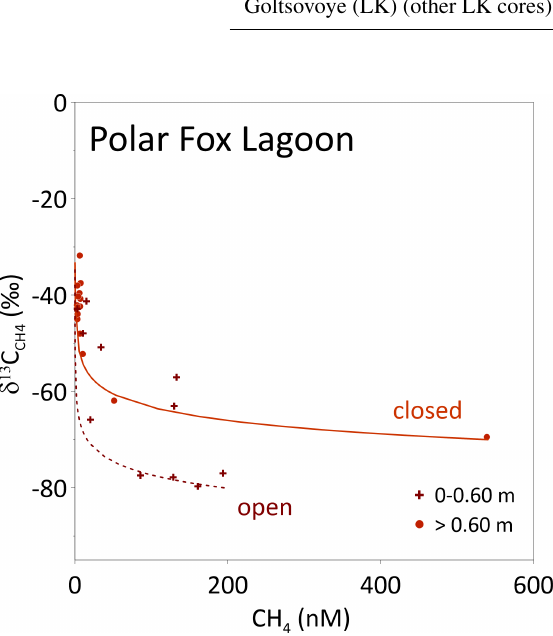
Figure 9. Observed δ 13 C CH and CH 4 concentrations in the ice 4 of Polar Fox Lagoon (LG) for shallow and deep ice (above and below 0.6m, respectively; shown as symbols). The lines show δ 13 C CH calculated based on Rayleigh fractionation during oxida- 4 tion (Eq. 1). For these modelled values, α was set to 1.004 and the initial δ 13 C CH values were 195nM (0 to 0.6m, dotted line) and 4 450nM ( > 0 . 6m, solid line) with initial isotopic signatures of − 80 and − 70‰,